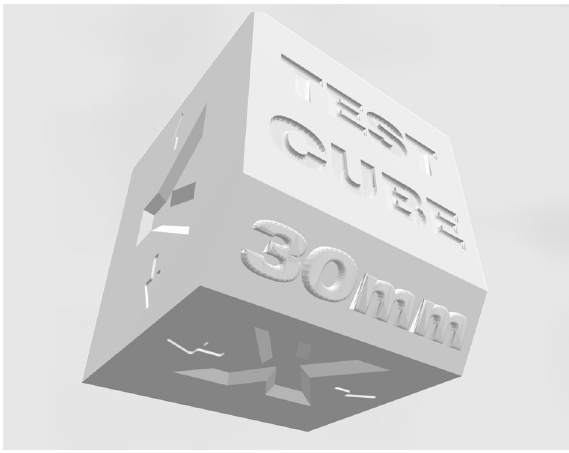
Fig. 1 The test cube STL. The 3D STL is shown virtually which was printed on each printer in the